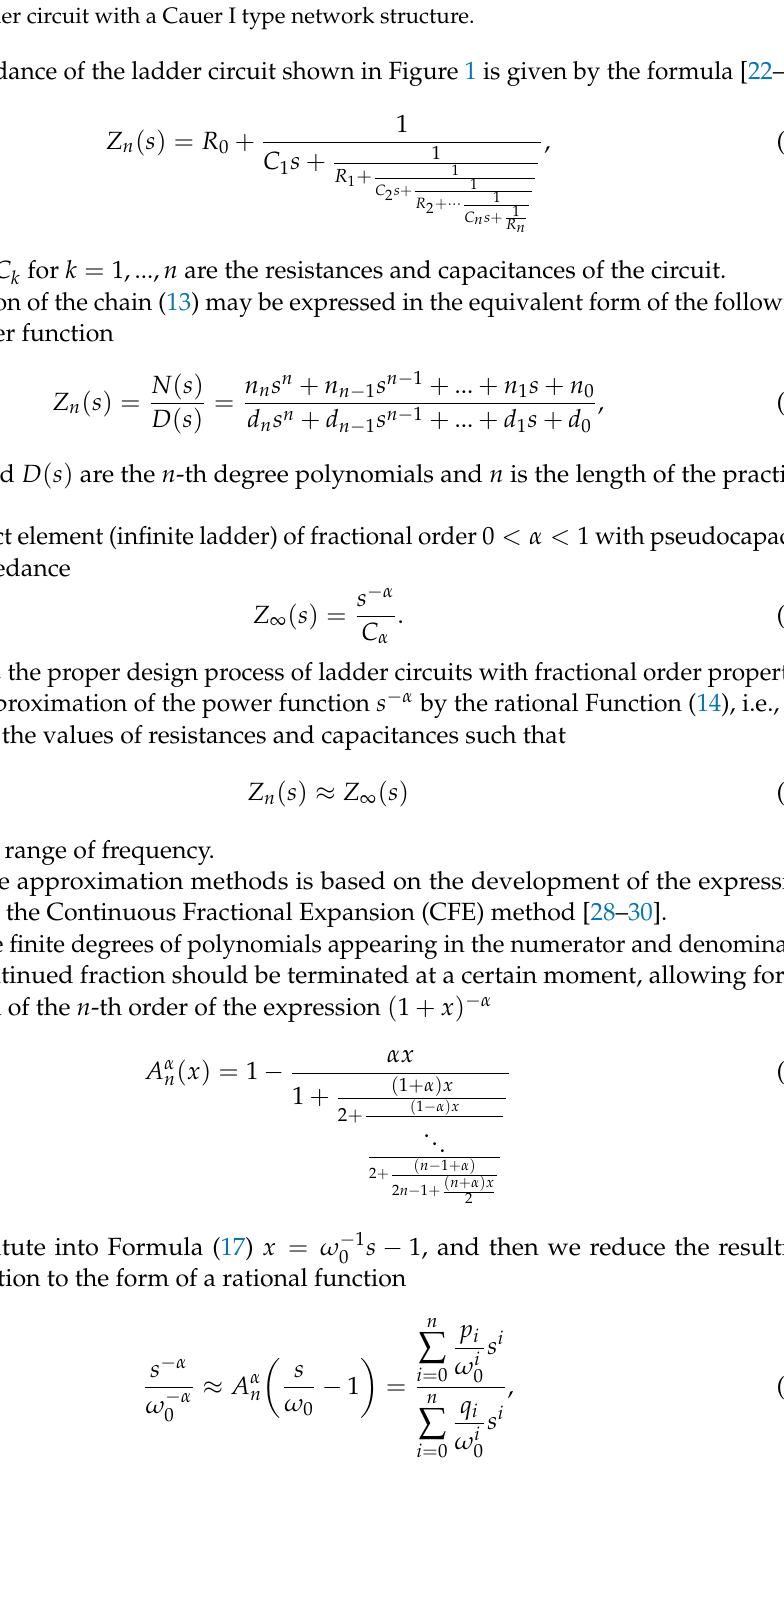
Figure 1. A ladder circuit with a Cauer I type network